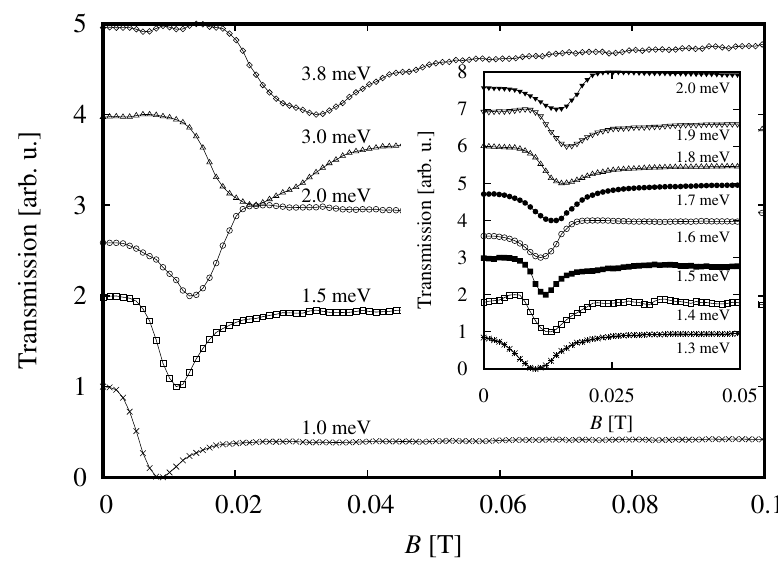
Figure 6. Transmission of a monochromatic radiation with photon energies indicated in the figure. In the case of transmission at 2.54 THz, a circular polarizer was placed close to the sample and the magnetic field was swept from negative to positive values. Then, σ + and σ − components of the transmitted signal were measured, as it is shown in Figure 7.